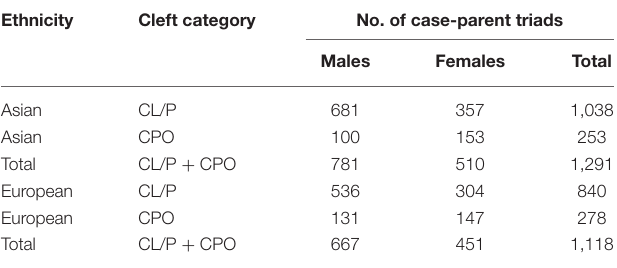
TABLE 1 | Number of case-parent triads according to ethnicity, cleft subtype, and child’s sex. Ethnicity Cleft